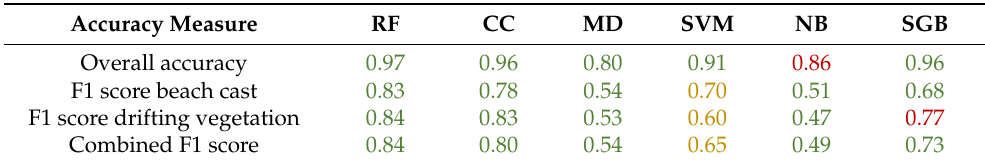
Table 1. Classification accuracies (overall accuracy, F1 scores, Combined F1 score) for the six classifiers with the band combination ‘B1’,‘B2’,‘B3’,‘B4’,‘B8’ for S-2 (green = higher than Table 2, yellow = equal to Table 2, red = lower than Table 2).